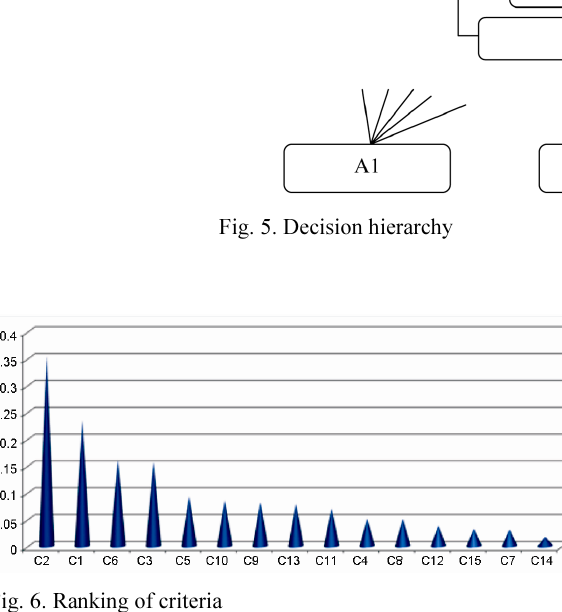
Fig. 6. Ranking of